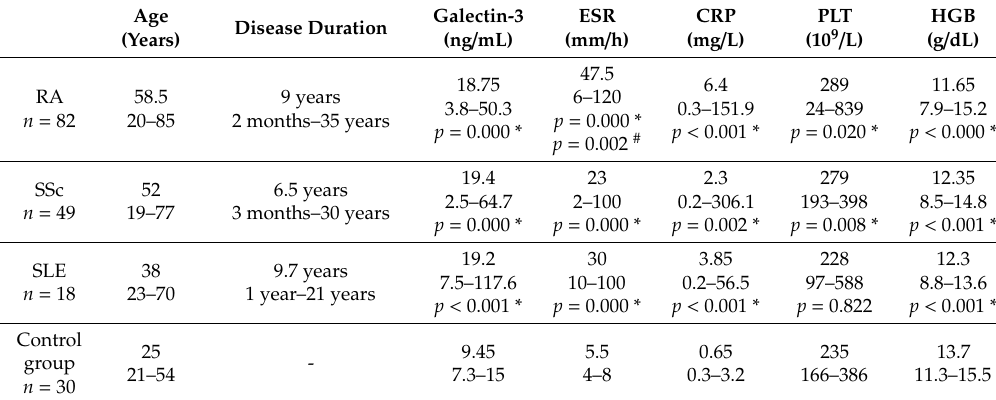
Table 1. Demographic and laboratory data of rheumatic patients and control group Age Disease (Years)